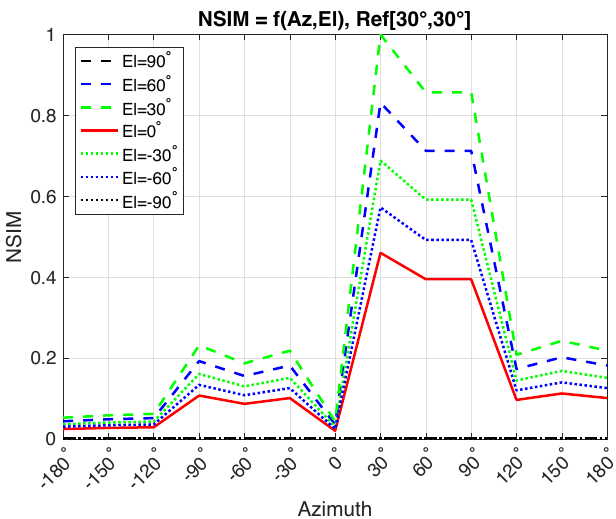
Figure 16. Localization accuracy as a function of azimuth and elevation. A fixed reference audio source is located at an offset point of azimuth = 30 ◦ , elevation = 30 ◦ . The asymmetry in results is caused by the source being closer to one ear than the other.